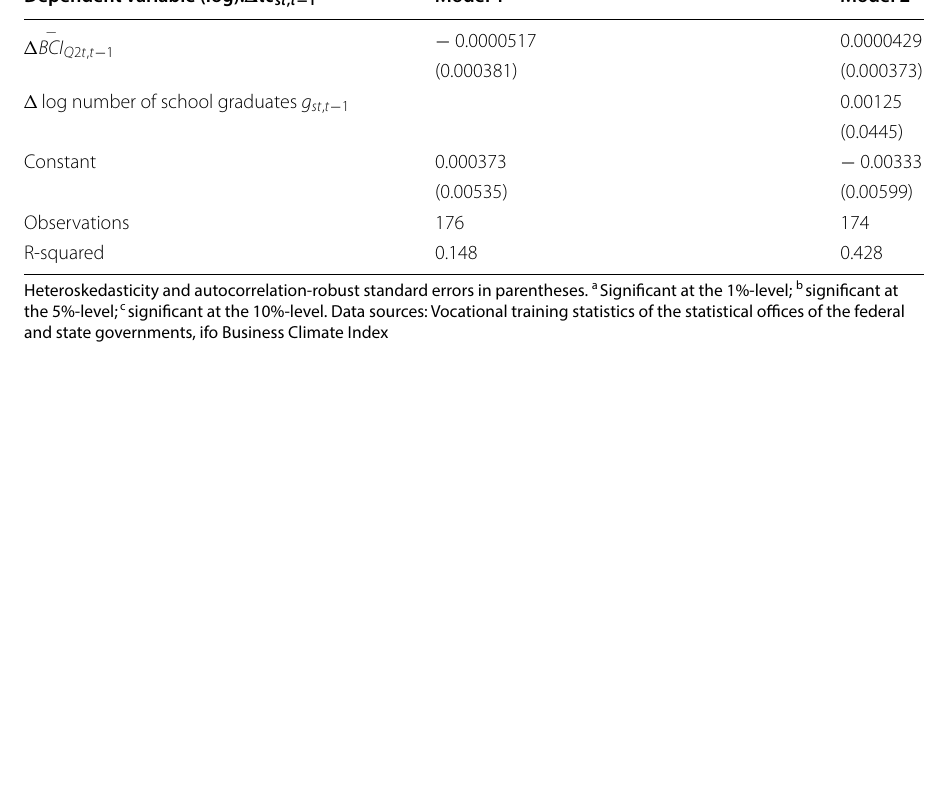
Table 8 First-differences regression, prematurely terminated training contracts (state- level)